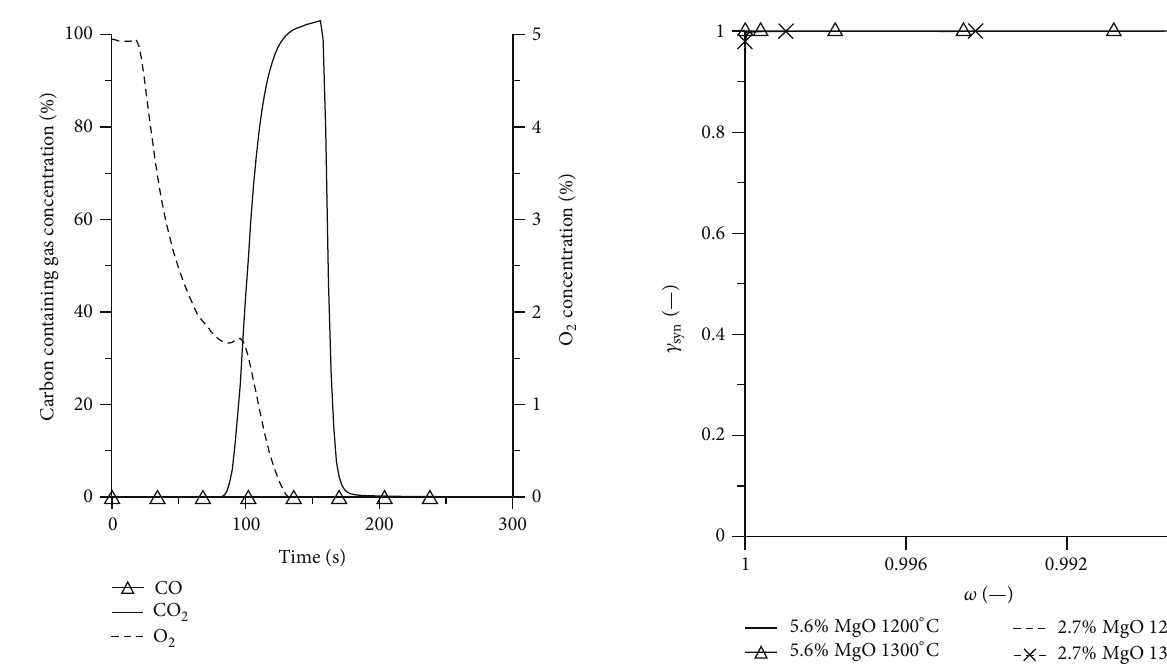
Figure 8: Syngas yield as a function of solid conversion for the second syngas cycle at 950 ∘